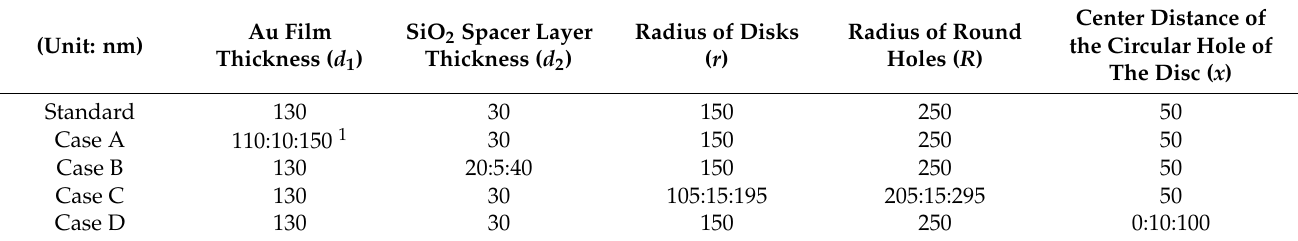
Table 1. Structural parameters for different